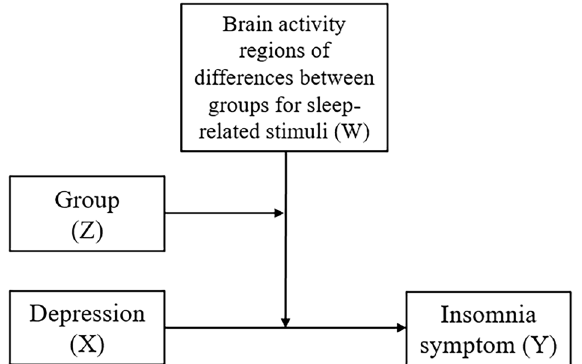
Figure 3. Moderated moderation model. A moderated moderation analysis was performed using the PROCESS macro (v3.0) for SPSS. In the model, group was entered as a moderator (Z) of the moderating effect of brain activity in response to sleep-related stimuli (W) on the association between sleep disturbances (dependent variable, Y) and depression (independent variable,